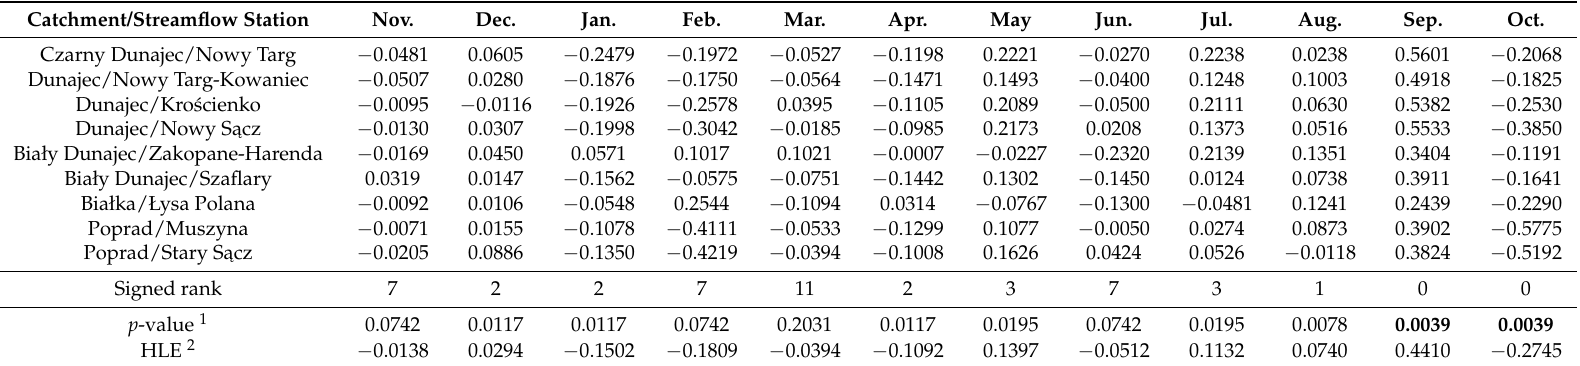
Table 6. Difference in the variability of monthly discharge determined by the coefficient of variability between the most recent 30-year period (1986–2015) and the previous period (1961–1985). According to the Wilcoxon signed rank test with the Bonferroni correction, the median of the difference in variability of discharge for each month is significant at p <